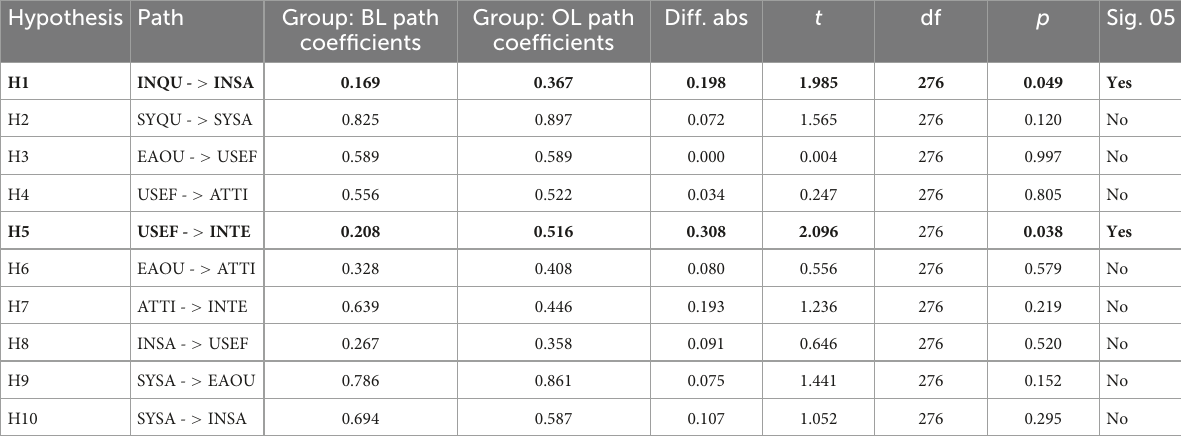
TABLE 4 Comparisons between BL and OL through